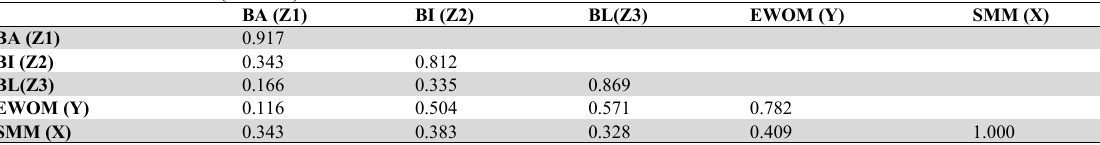
Fornell Lacker Criterion (HTMT)